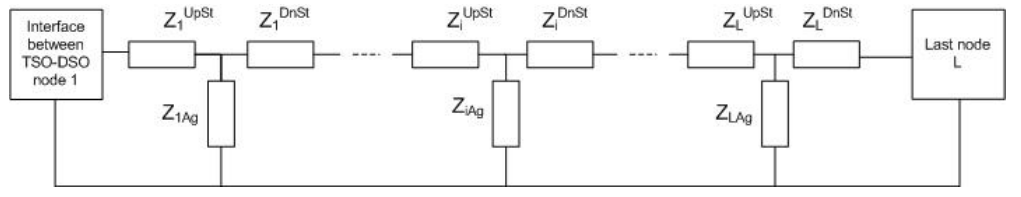
Figure 2. Overall aggregated impedance calculation.